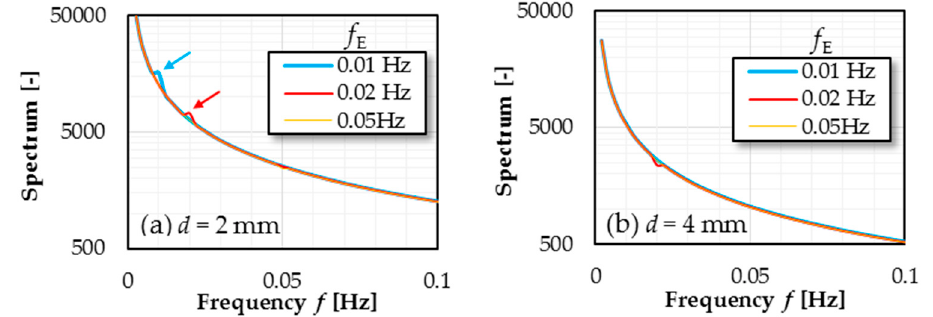
Figure 4. Numerically obtained frequency spectra of thermal waves that are reflected at the rear surface when plate thickness (defect depth) is ( a ) 2 mm and ( b ) 4 mm.